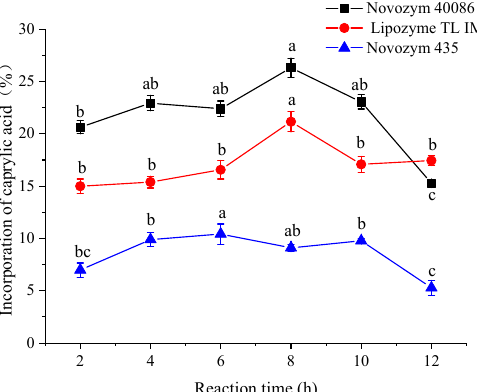
Figure 1. Effect of reaction time on incorporation of caprylic acid into corn oil by different lipases. Reaction conditions: 200 W ultrasonic power, 10 min pretreatment time, 1:6 corn oil/CA molar ratio, 12% enzyme dosage, and 5 mL of hexane, 50 °C. Different letters indicate significant differences.